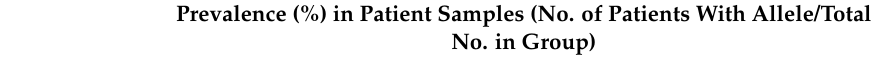
Table 3. Matched post-treatment allele